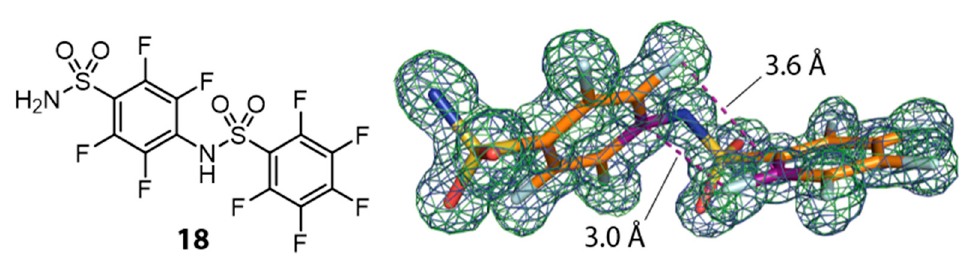
Figure 7. Valence bond formula of dimerization product 18 (left) and crystallographic model from the Human Carbonic Anhydrase II (hCAII) complex with 2mFo-DFc map contoured at 1 σ and mFo-DFc map in green at 3 σ (right). Carbon atoms are shown in orange, fluorine atoms in light blue. Carbon atoms used to display intramolecular π -stacking are shown in purple. π -Stacking interactions are indicated as purple dashed lines with the respective distances between atomic positions of F and C.